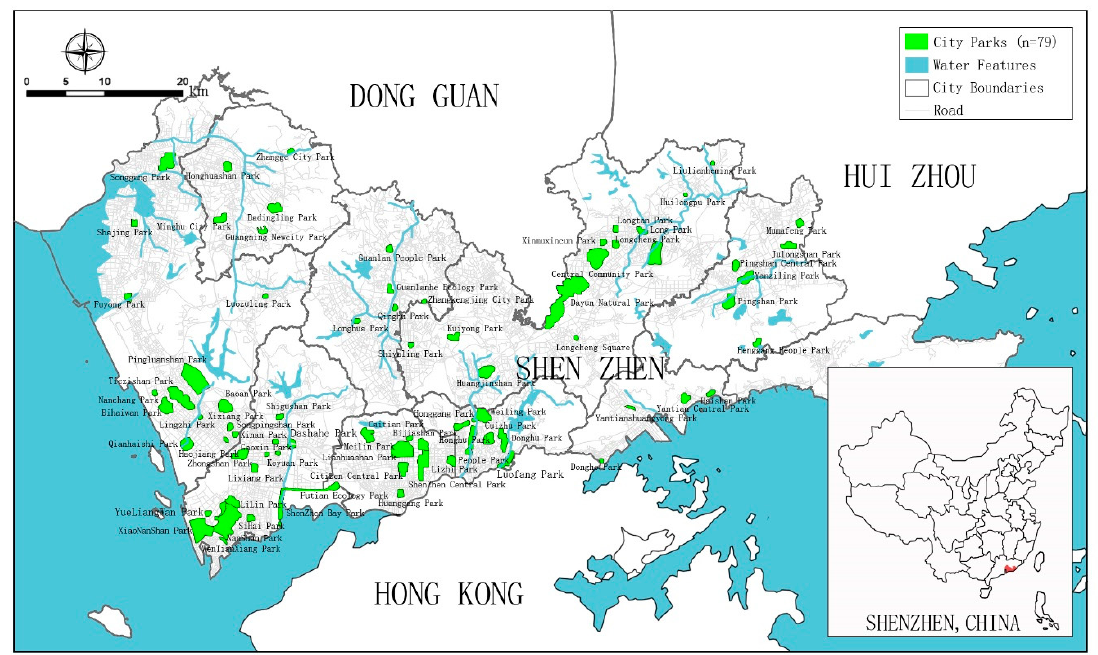
Figure 1. The distribution of sample parks (drawn by the authors).